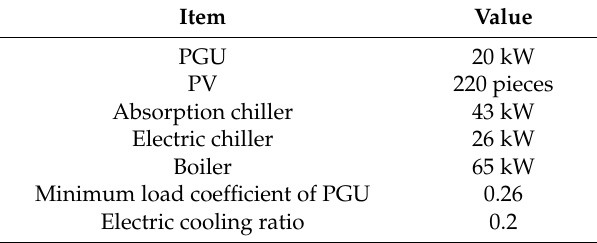
Table 11. Optimal results of the RES–CCHP system.